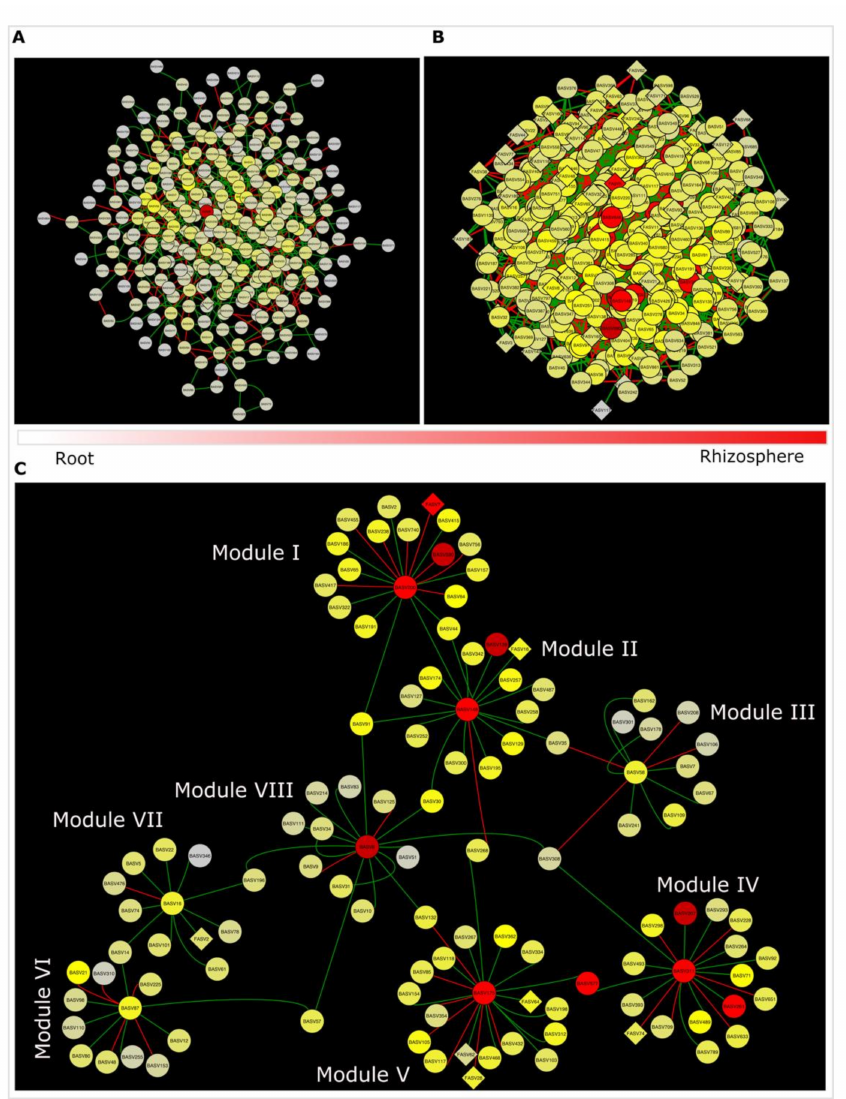
Figure 6. Network analysis in soybean microbiome. Inter-kingdom network in the root ( A ) and rhizosphere ( B ) biotopes. The node shapes represent bacterial (circular) and fungal (rhombus) communities. Nodes are coloured according to the relative abundance of the corresponding ASVs. The ribbon shows the relative complexity of the inter-kingdom network in root and rhizosphere biotopes. ( C ) A network build from ASVs of hub taxa and their inter-connection clustered into eight different modules. Each node represents an ASV from the microbiome. Green link represents a positive interaction and red link represents a negative interaction. Nodes are coloured according to the relative abundance of the corresponding ASVs, and node shapes denote bacterial (circular) and fungal (rhombus) ASVs. Details of the ASVs corresponding global hub taxa are in Table